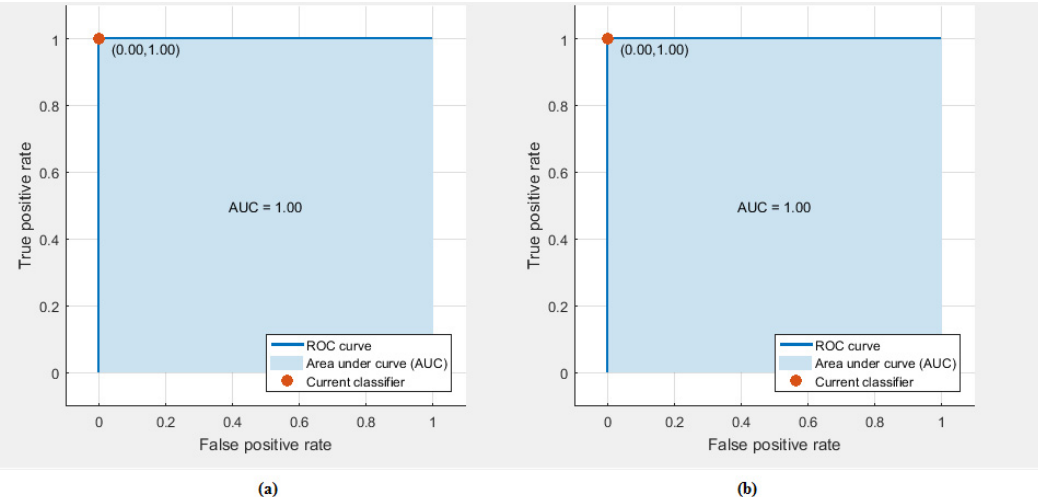
Figure 5. Receiver operating characteristic (ROC) curves for detecting stress and non stress; ( a ) cubic Table 3. Evaluation metrics (with their 95% confidence intervals) for detecting stress using Feature-Set